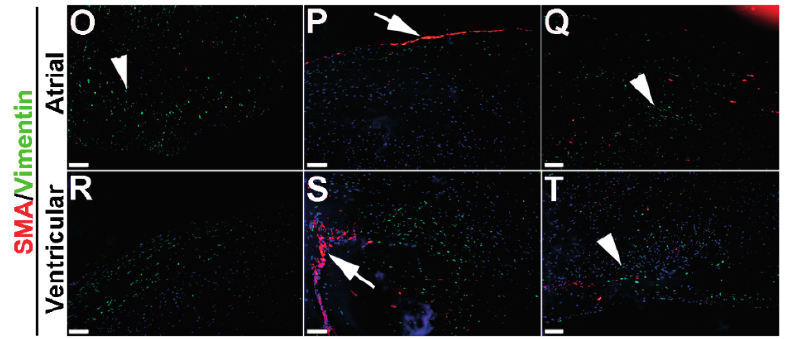
Figure 8. VIC phenotypes in diseased human myxomatous mitral valve biopsies. ( A , H ) Pentachrome staining to show extracellular matrix composition and organization in control ( A ) and myxomatous ( H ) mitral valves from human patients. ( B – G , I – T ) Immunohistochemistry to detect expression of smooth muscle α -actin (SMA) with Periostin ( B – D , I – N ) and Vimentin ( E – G , O – T ) in cells within the mitral valve leaflet of control ( B – G ) and myxomatous ( I – T ) patients. Arrows indicate SMA expression (red)